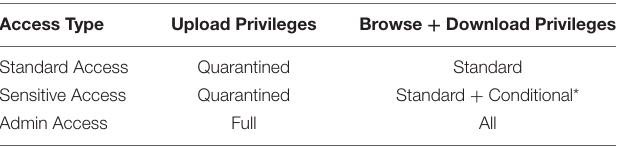
TABLE 1 | Access and permission rights for users of the INR. Access type will be approved by the database administration team and will be determined based on use case and contributions.